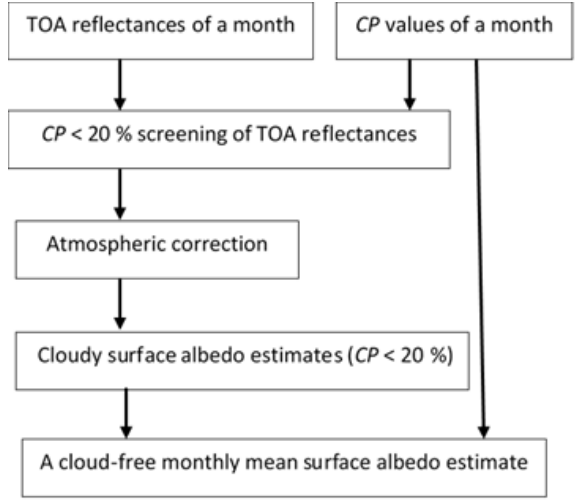
Figure 2. Flow diagram of the estimation of cloud-free monthly mean surface albedo values on pixel basis starting from the TOA reflectance and CP values of the month in